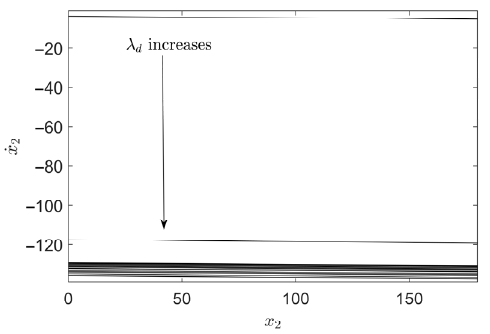
Figure 4. The family of first order differential equations for the RSMC stability analysis case.